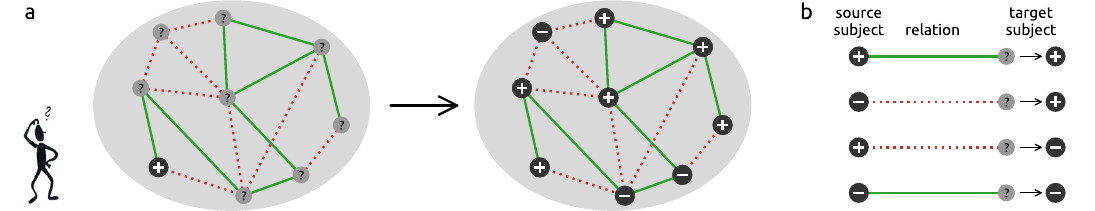
Fig. 1 The opinion formation model. a An observer faces a set of subjects that are interconnected by mutual relations of trust (solid green lines) or distrust (dotted red lines). Starting from a small set of seed opinions (here one positive seed opinion marked with + in a black circle) and a world of unknown subjects (gray circles), the observer gradually forms opinions on all subjects. b The formed opinion is determined as a product of the opinion on a chosen source subject (one of the seed subjects or any other subject on which an opinion has been already made) and the sign of the relation between the source subject and the target subject. A positive opinion is formed when the source opinion and the relation are both positive or both negative; a negative opinion is formed